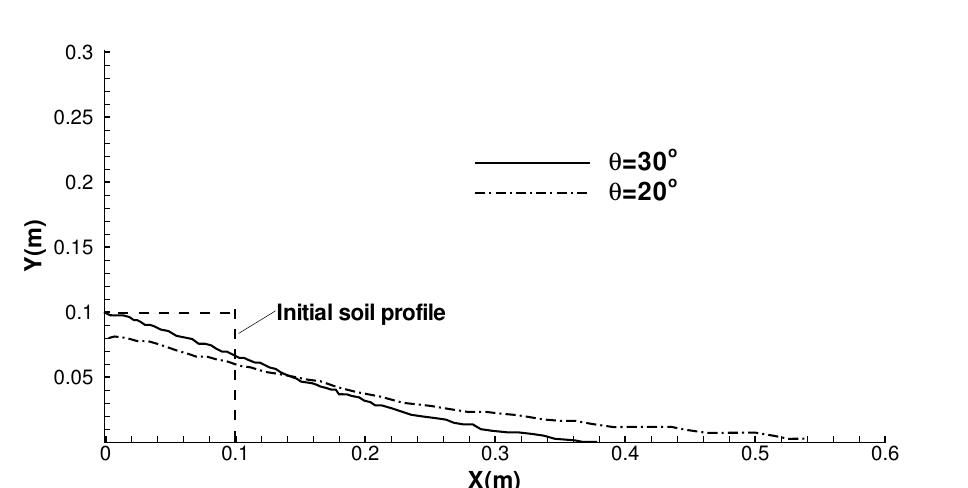
Figure 4. Influence of the internal friction angle θ on the morphology of the deposit for dry granular column collapse. Soil profiles at t = 0.5 s are plotted.